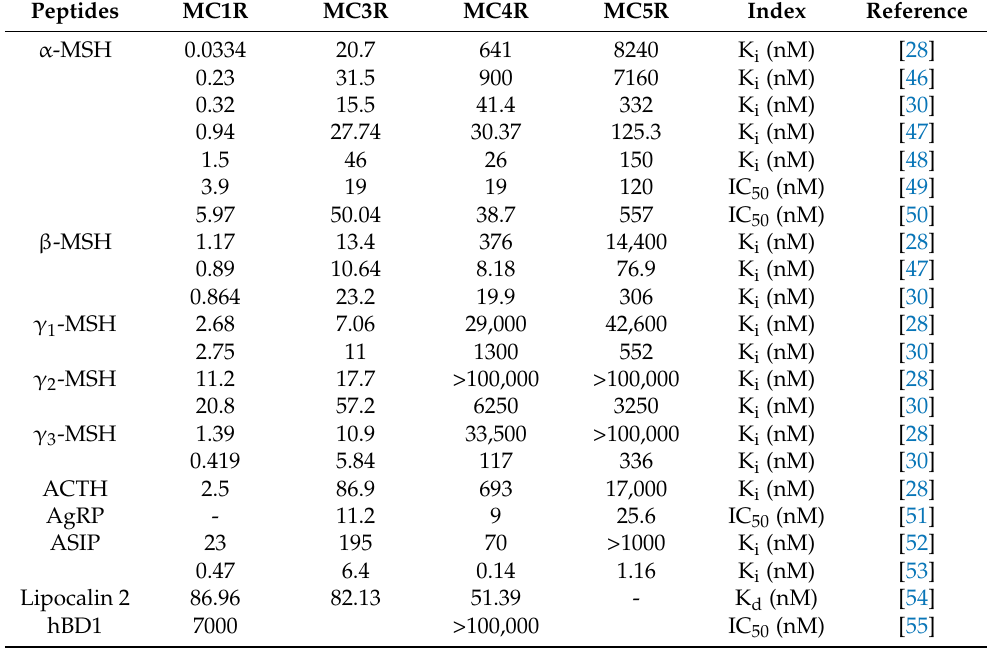
Table 2. Binding affinities of melanocortin ligands at human melanocortin receptors.